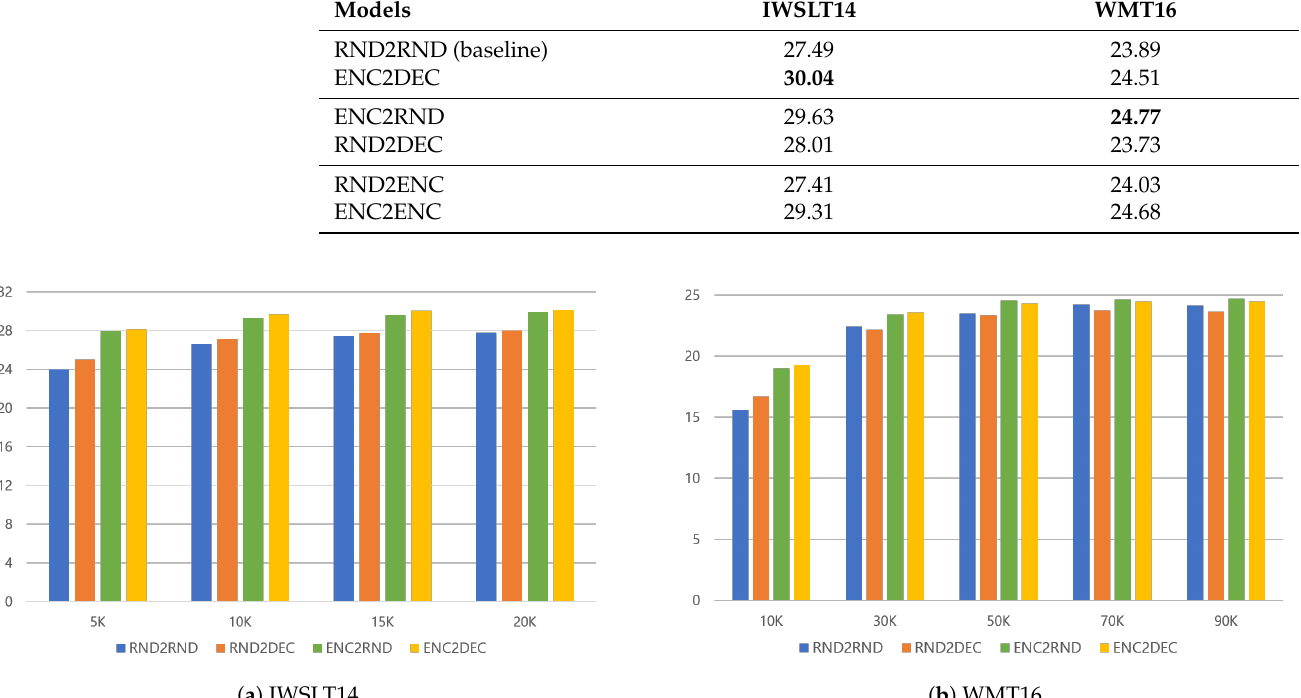
Figure 4. BLEU scores of the IWSLT14 En-Ro dataset and WMT16 En-Ro dataset along with the training